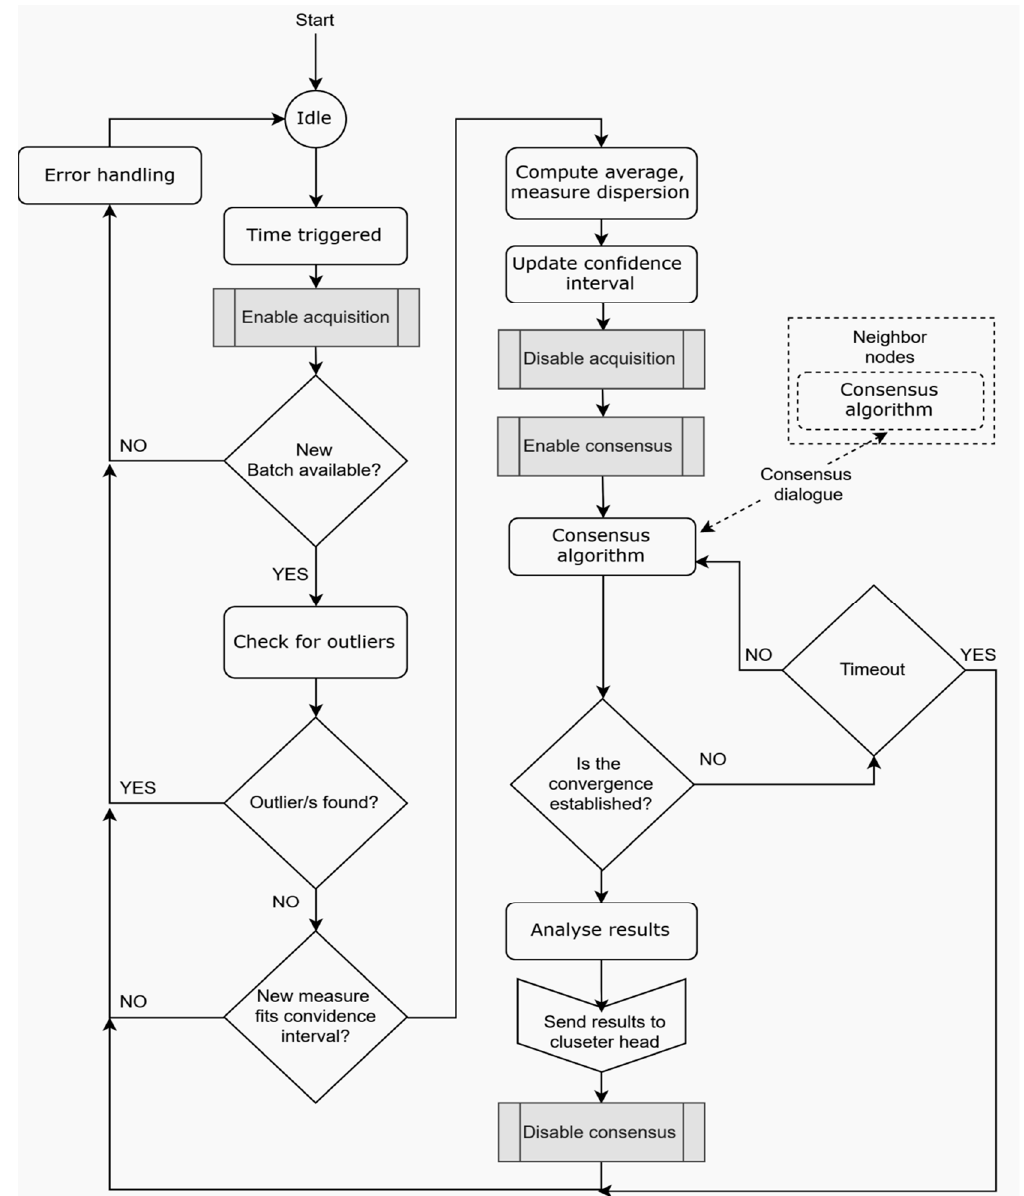
Figure 4. Flow diagram of the data processing steps at the field level, based on consensus algorithm.